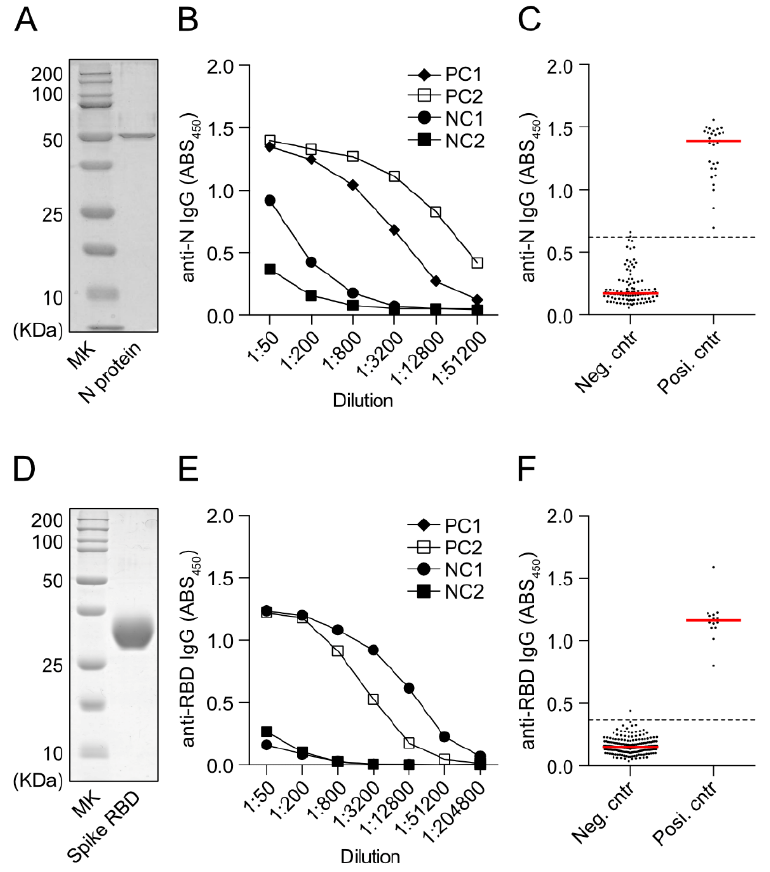
Figure 2. Measurement of anti-SARS-CoV-2 N-protein IgG antibody and anti-SARS-CoV-2 S-protein RBD IgG antibody by enzyme-linked immunosorbent assay (ELISA). ( A ) SDS-PAGE of purified recombinant SARS-CoV-2 N protein (0.4 µ g). ( B ) Initial set-up ELISA to detect anti-N-protein IgG using serially diluted COVID-19 patients serum samples (PC1, PC2) and negative controls (NC1: pooled serum, Cosmo bio KOJ-12181201, NC2: clinical sample obtained before the COVID-19 epidemic). ( C ) Serum reactivity of control ( n = 100) and COVID-19 patients ( n = 29) to SARS-CoV-2 N protein. ABS450 values of 400-fold diluted serum are shown. Control serum was collected before SARS-CoV-2 spread in Japan and serum samples of COVID-19 patients were collected later than 14 days after the disease onset. ( D ) SDS-PAGE of recombinant SARS-CoV-2 RBD protein (5 µ g). ( E ) Initial set-up ELISA to detect anti-RBD IgG using serially diluted COVID-19-patient serum samples (PC1, PC2) and two negative controls (NC1, NC2). ( F ) Serum reactivity of control ( n = 199) and COVID-19 patients ( n = 14) to SARS-CoV-2 RBD protein. ABS450 values of 200-fold diluted serum are shown. Red lines indicate median.